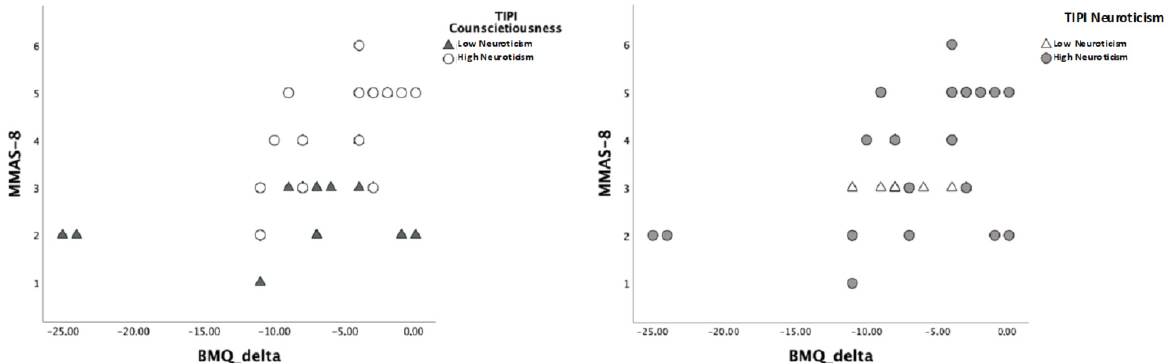
Figure 1. Relationship between Δ BMQ and MMAS-8 scores according to different levels of I-TIPI Conscientiousness and Neuroticism.